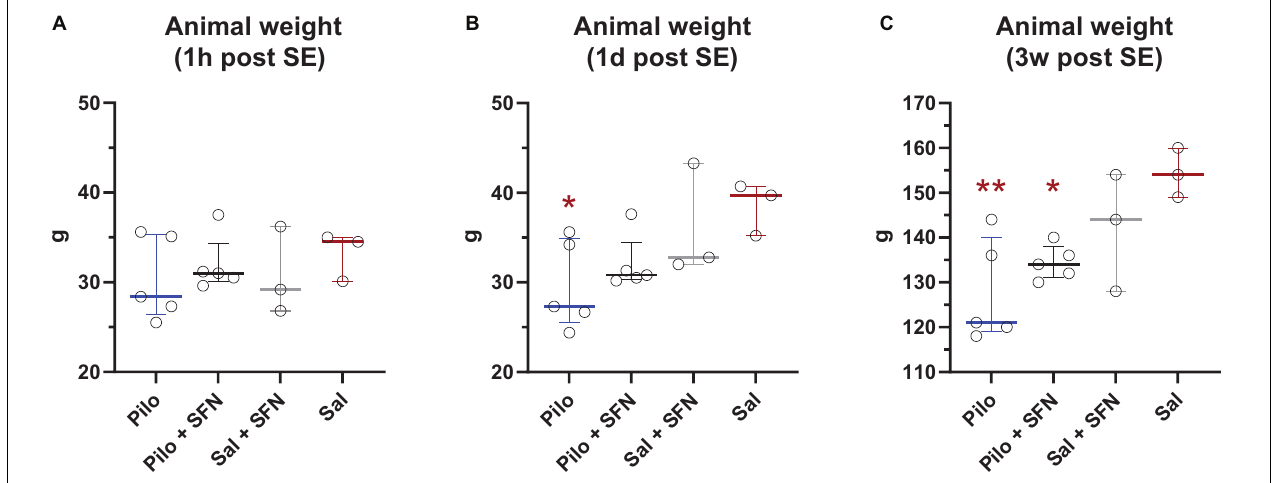
FIGURE 2 | Effect of SFN on animal weight. 1 h post SE, we observe no statistically significant weight changes between the groups (A) . We observed reduced weight in SE groups 1 day (B) and 3 weeks after SE (C) . SFN has no effect on weight gain neither in the Saline nor in the SE groups (The Kruskal–Wallis test was followed by uncorrected Dunn’s test comparing all other groups to the Saline group, * P < 0.05 vs. Sal group). All values are reported as median ± interquartile range. ** P < 0.01.